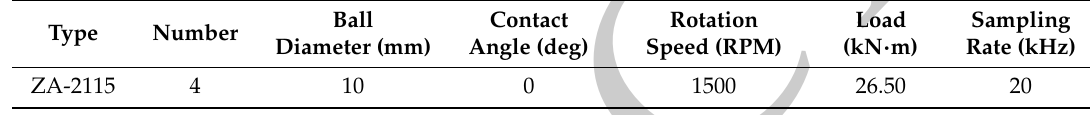
Figure 4. Test rig. Table 3. Bearing parameters and experimental conditions.